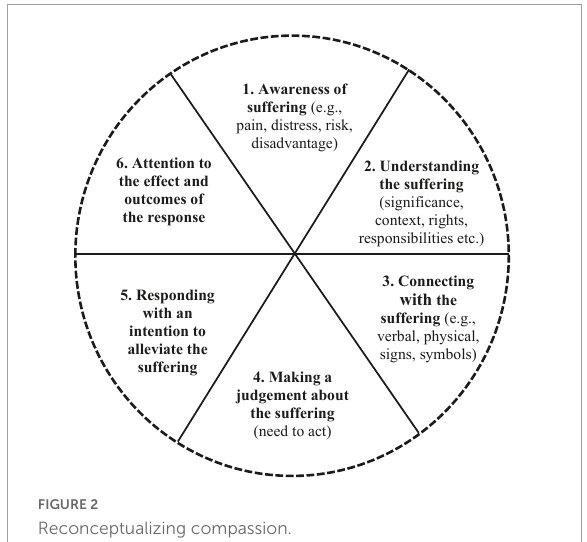
FIGURE2 Reconceptualizing compassion.